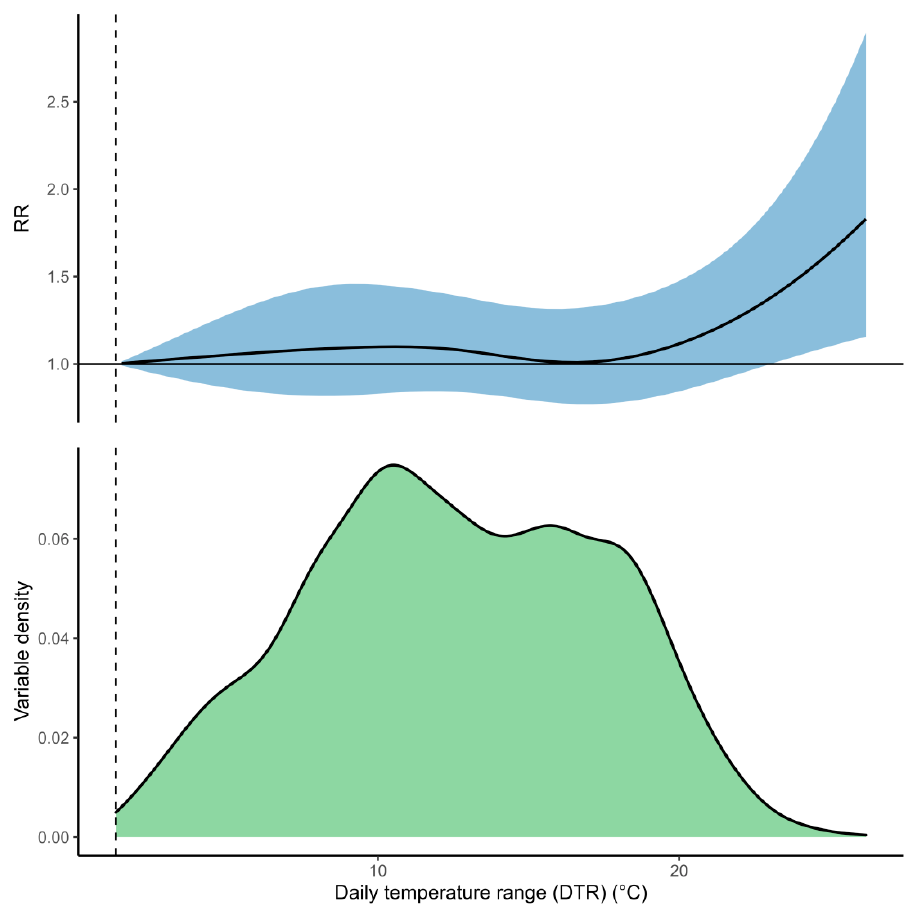
Figure 7. The top panel shows the association between daily temperature range (DTR) and pneumonia hospital admissions. No lagged association was modelled for this exposure, so this represents the association on any given day (i.e., zero days lag). The solid curve is the predicted relative rates (RR), and the shaded region is the 95% CI. The lower panel shows the distribution of DTR within the iDEWS dataset. The optimal lowest DTR in the dataset (1.3 °C) is indicated by the dashed vertical line and is used as the reference value against which the RR for other DTR values is compared. Table 1. Proportion of pneumonia hospital admissions attributable to changes in meteorological exposures (AF = attributable fraction), shown as the total AF, the AF due to lower values of the exposures, and the AF due to higher values of the exposures. ± changes in meteorological exposures indicate how the AF would change if the exposure distribution was shifted positively or negatively by the specified